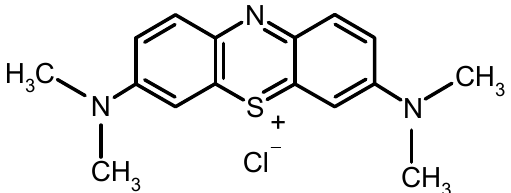
Fig. 1: Molecular structure of Methylene Fig. 1. Molecular structure of Methylene blue.